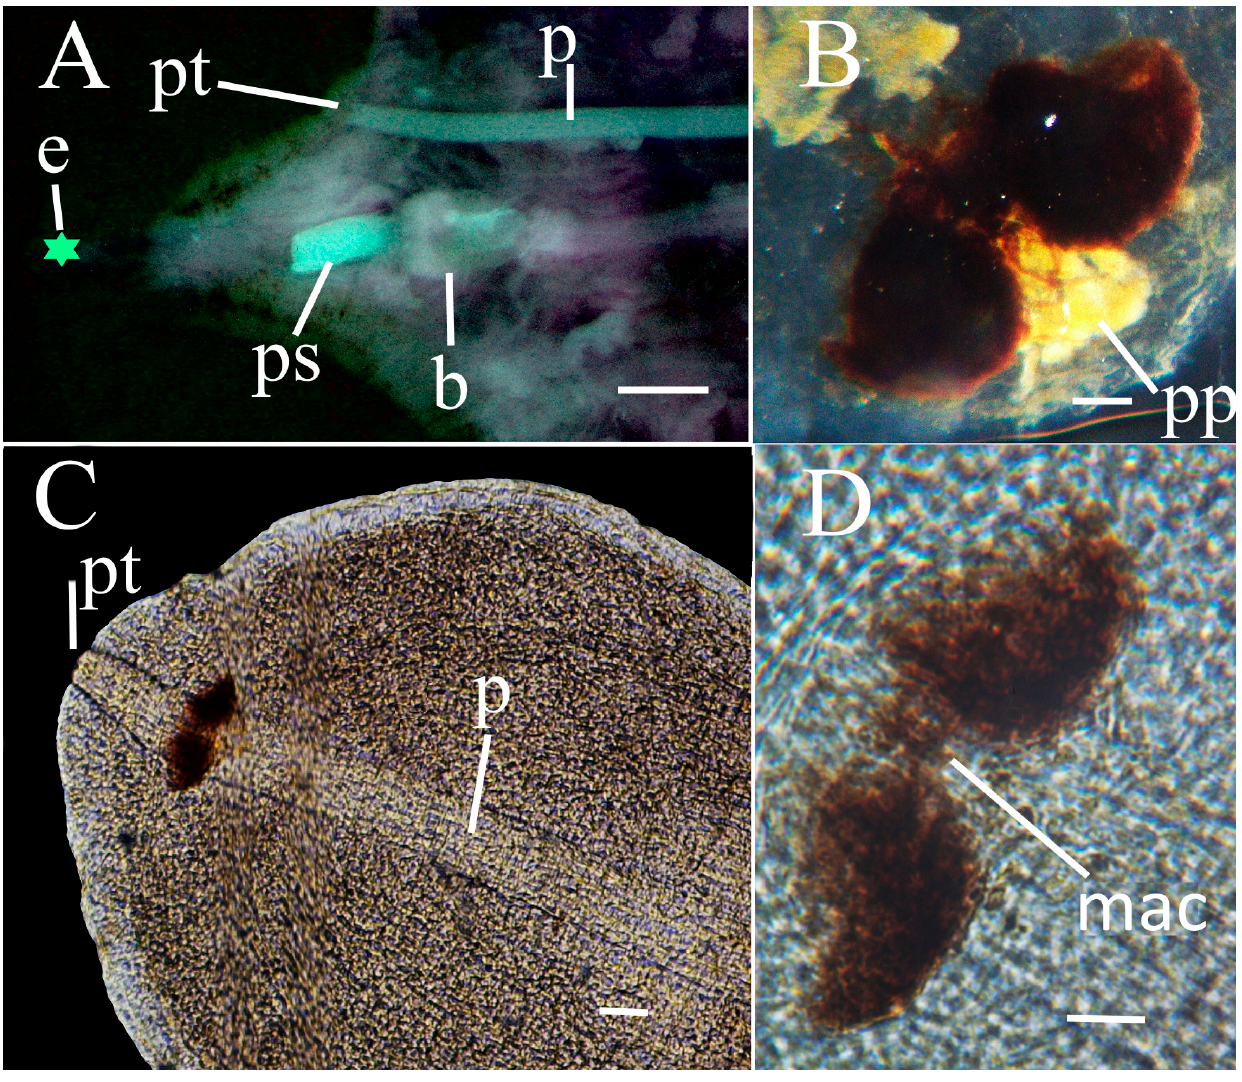
Figure 5. The anterior proboscis and eyes of adult and recent hatchling of P. parasitica are remarkably similar. ( A , B ) PP-4a, 39.8 mm. ( C , D ) P-4b, 6.0 mm, hatchling of foregoing. The proboscis of both adults and hatchlings tapers to a remarkably narrow tip which, when retracted, extends anterior to the brain. Abbreviations: b, brain; e, location of eye in situ; mac, median annectant eye cells; p, proboscis (dissected from sheath in A ); pp, placobdellid head pattern (precursor cells); ps, proboscis sheath (anterior to brain); pt, tip of proboscis. Scale bars: ( A ) 0.5 mm; ( B ) 100 μ m; ( C ) 10 μ m; ( D ) 3.0 μ m.